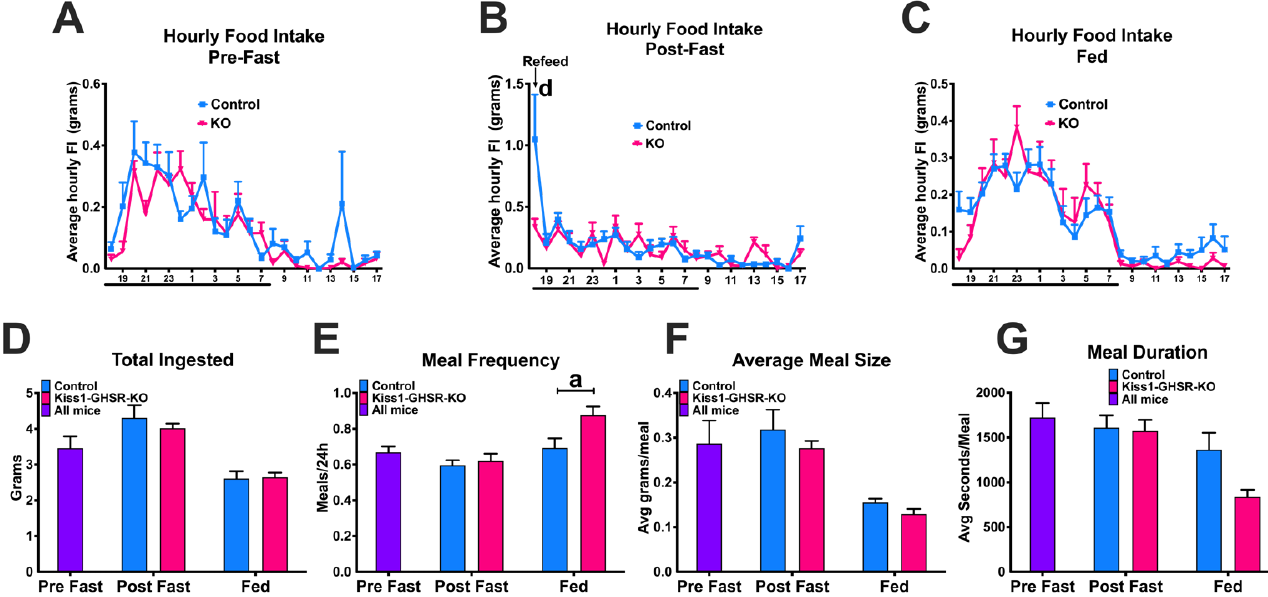
Figure 7. Meal pattern analysis intact control and Kiss1-GHSR KO (KO) female mice on normal chow diet. ( A ) Average hourly food intake for control and KO females 24 h before fasting. ( B ) Average hourly food intake for control and KO females 24 h after fasting. ( C ) Average hourly food intake for control and KO females 24 h of non-restricted feeding. ( D ) Total food ingested over 24 h before fasting, 24 h after fasting, and fed normally. ( E ) Meal Frequency Average 24 h before fasting, 24 h after fasting, and fed normally. ( F ) Average meal size (grams) 24 h before fasting, 24 h after fasting, and fed normally. ( G ) Average meal duration 24 h before fasting, 24 h after fasting, and fed normally. For Lowercase letters denote significance between control and KO females. Lowercase letters above capped lines denote significance between genotypes withing the same treatment (a = p < 0.05; b = p < 0.01; c = p < 0.001; d = p < 0.0001). Data are represented as mean ± SEM and n = 14 controls and n = 8 Kiss1-GHSR KO mice per group. Data were analyzed with two-way ANOVA with post